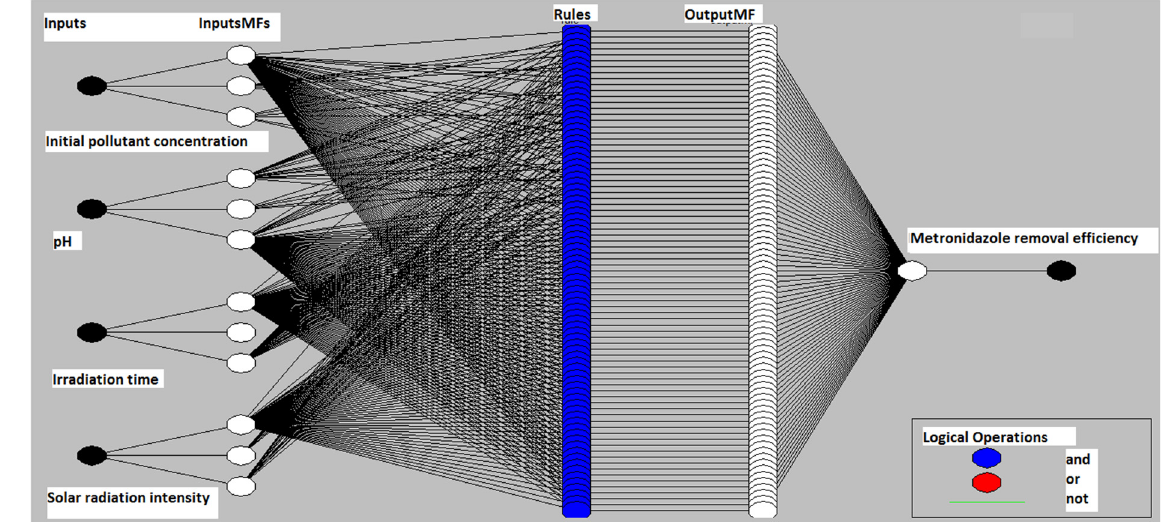
Figure 2. Schematic representation of the five-layer architecture of an artificial neuro-fuzzy inference system (ANFIS) model and the photocatalytic process variables used as inputs.